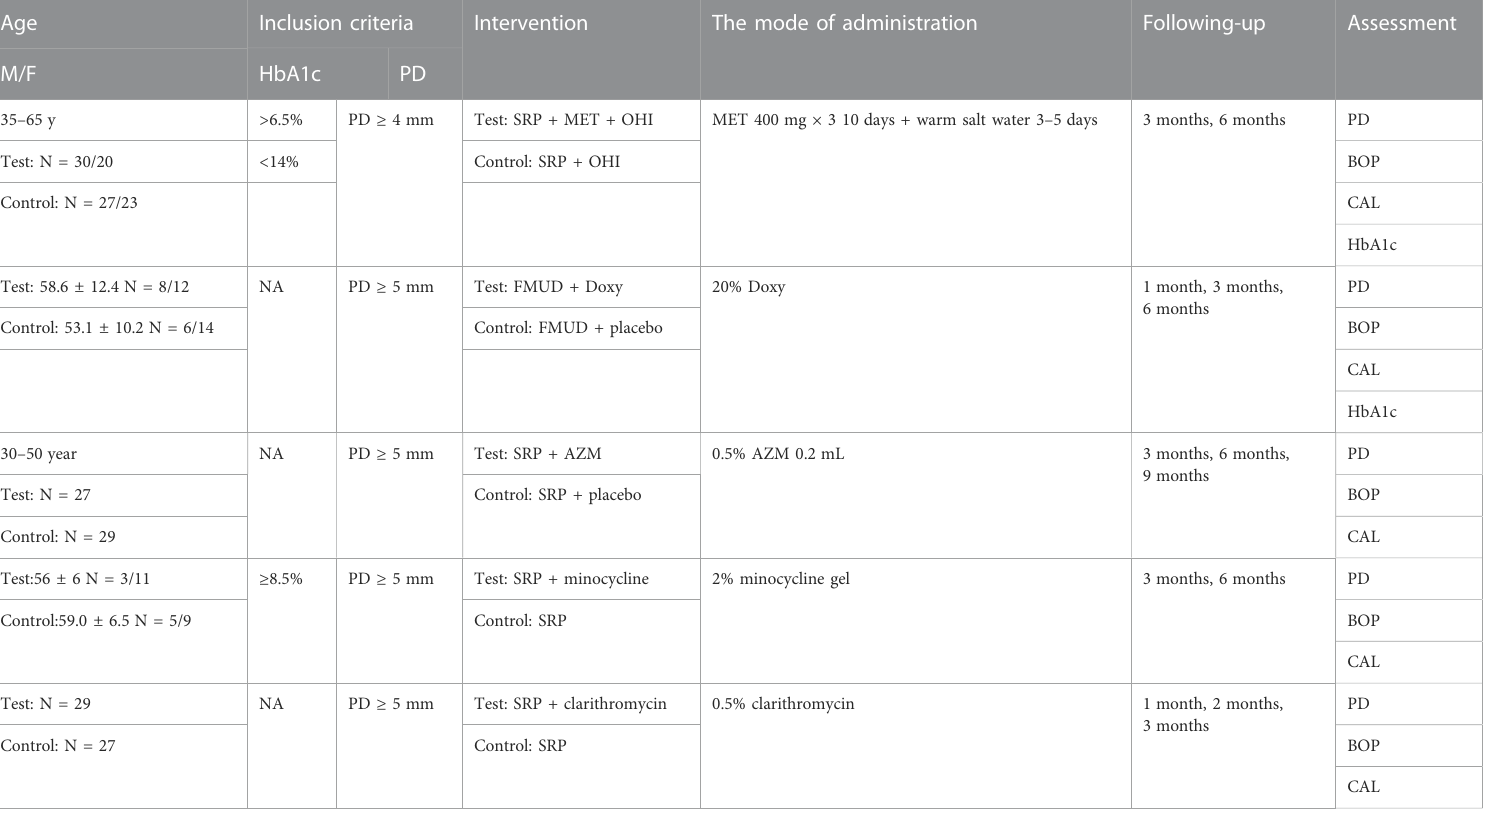
TABLE 2 General information provided in the included studies —— topical